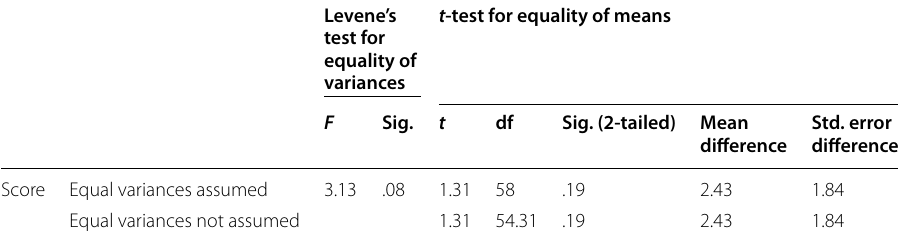
Table 27 Inferential statistics (learner autonomy pre‑test of both groups)